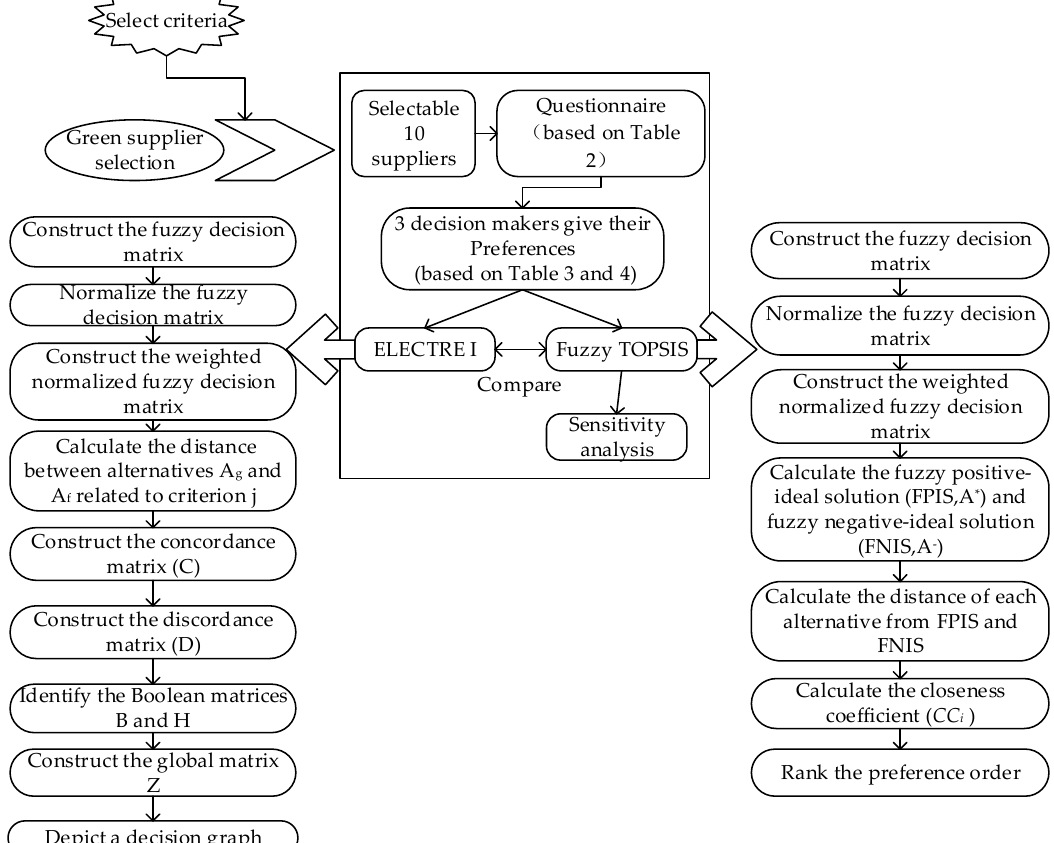
Figure 1. Proposed framework used in this paper.